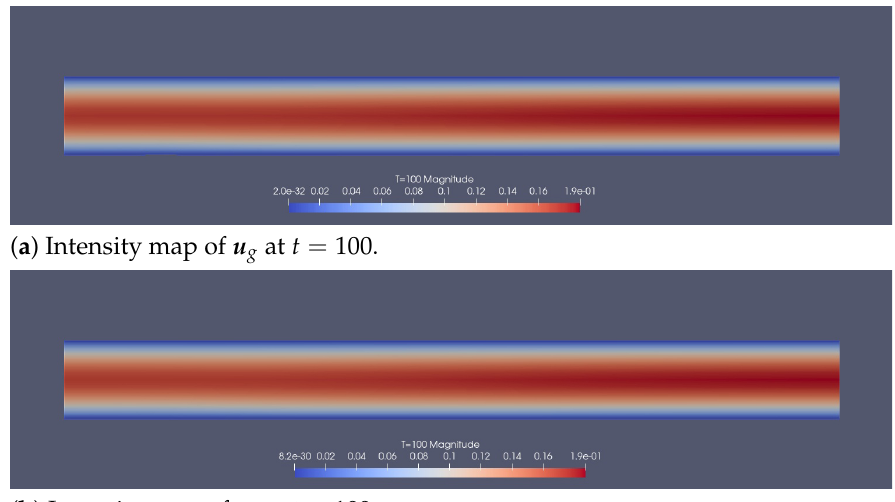
( b ) Intensity map of u l at t = 100. Figure 12. For Section 5.2: The velocity magnitudes of u g and u l